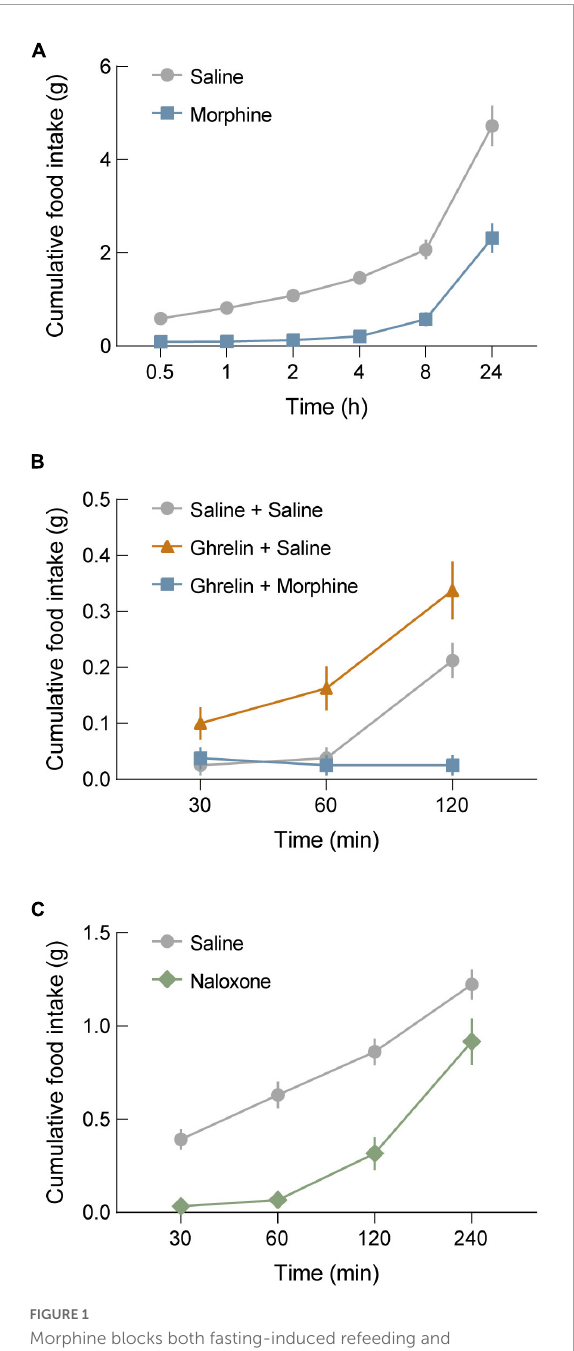
FIGURE1 Morphine blocks both fasting-induced refeeding and ghrelin-stimulated refeeding. (A) Morphine administration (20 mg/kg, s.c. before fasting; 40 mg/kg, s.c. before refeeding) in wild-type (WT) mice blocks fasting-induced refeeding. (B) Ghrelin administration in WT mice significantly increases food intake compared to saline controls. Co-administration of morphine with ghrelin completely occludes ghrelin-stimulated feeding behavior. (C) Administration of the µ -opioid receptor antagonist naloxone (5 mg/kg, s.c.) blocks fasting-induced refeeding in WT mice. See Supplementary Table 1 for details on statistical